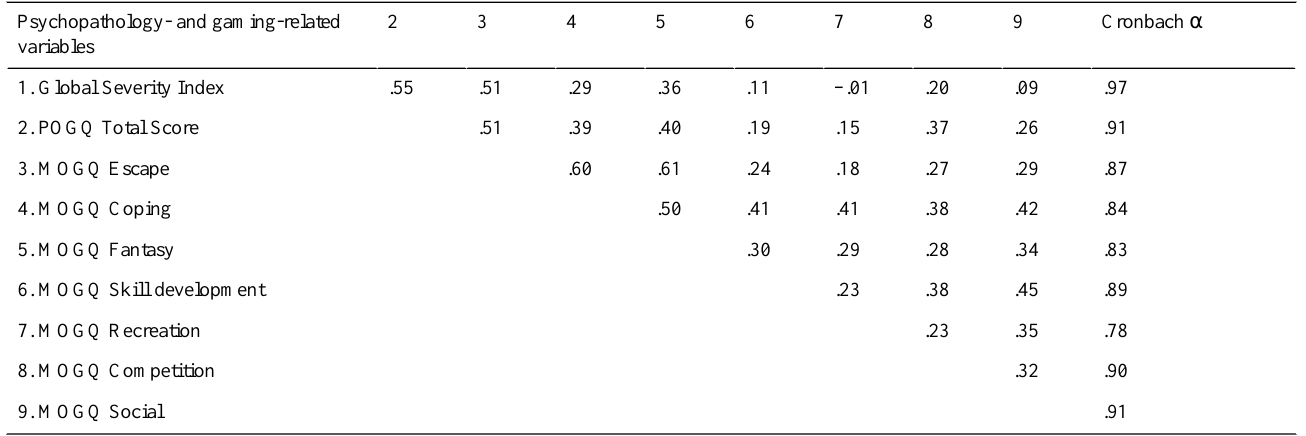
Table 4. Zero-order correlations and Cronbach alphas